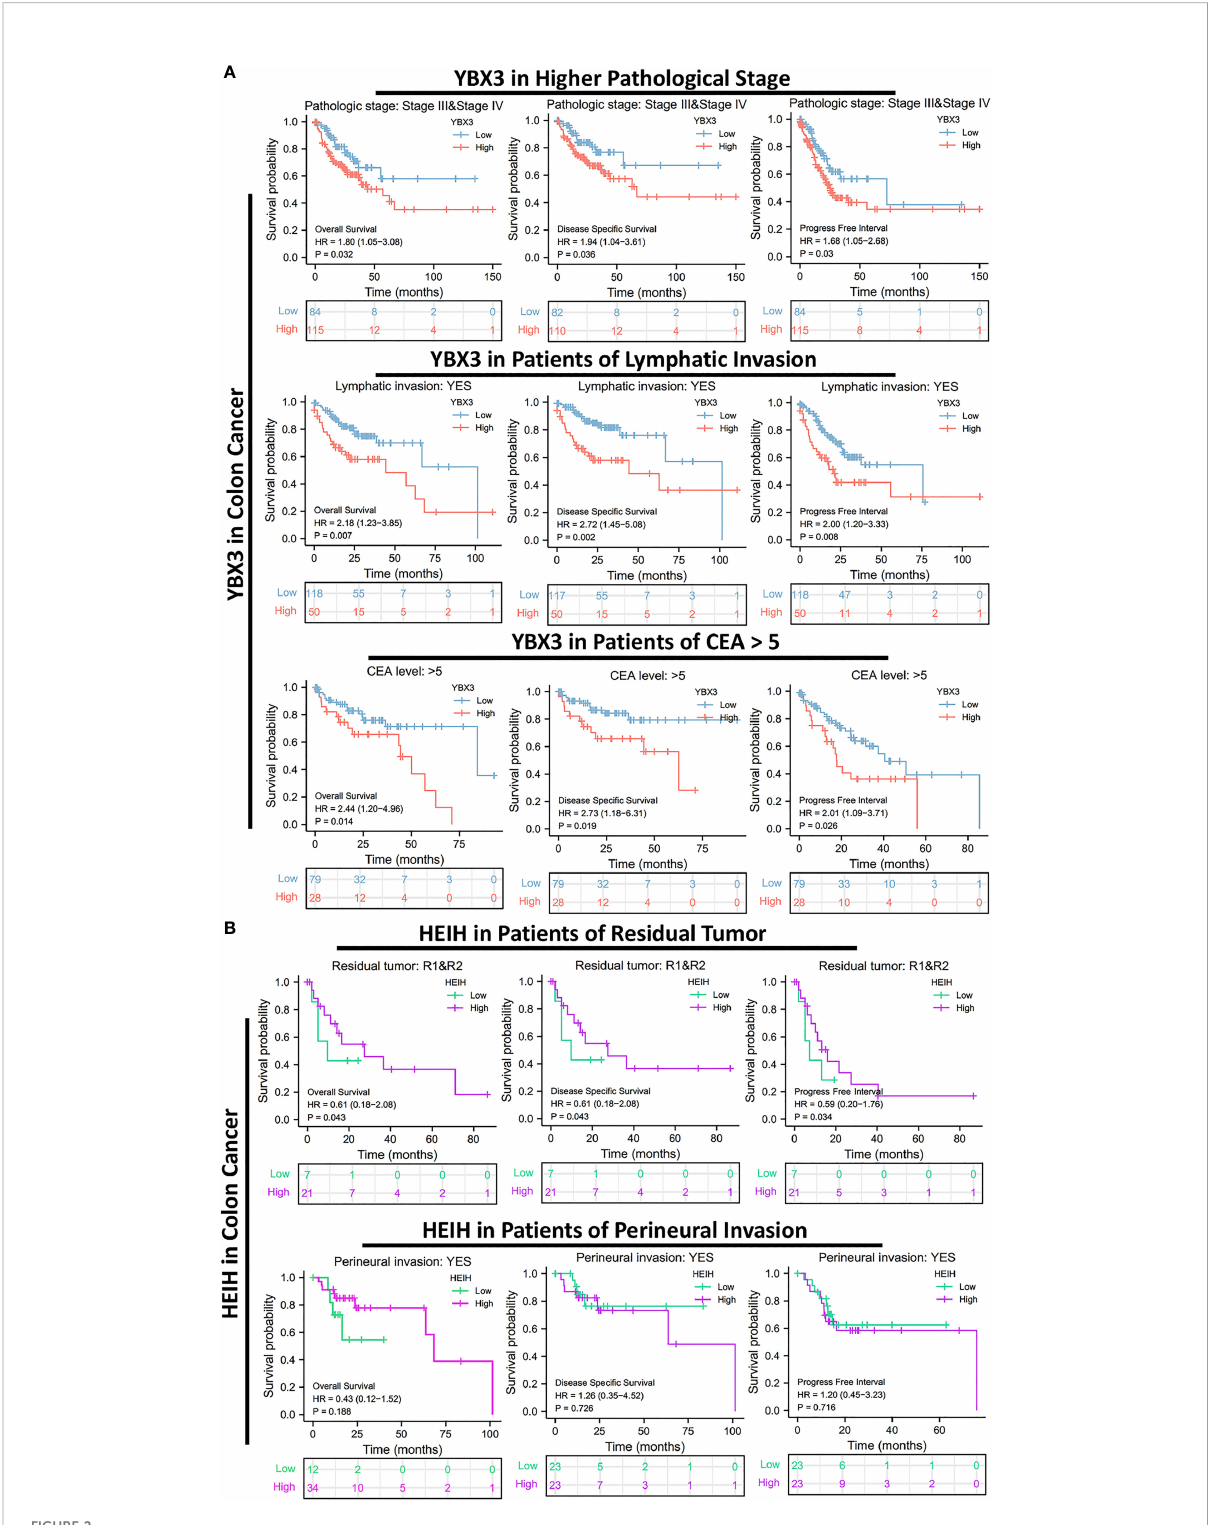
FIGURE 2 Associations between HEIH/YBX3 expression and the prognosis in different clinical subgroups of colon cancer. (A) Effect of YBX3 expression on colon cancer of higher pathological stage, cohorts of lymphatic invasion, and CEA >5. (B) Effect of HEIH expression on colon cancer of patients with residual tumor and perineural